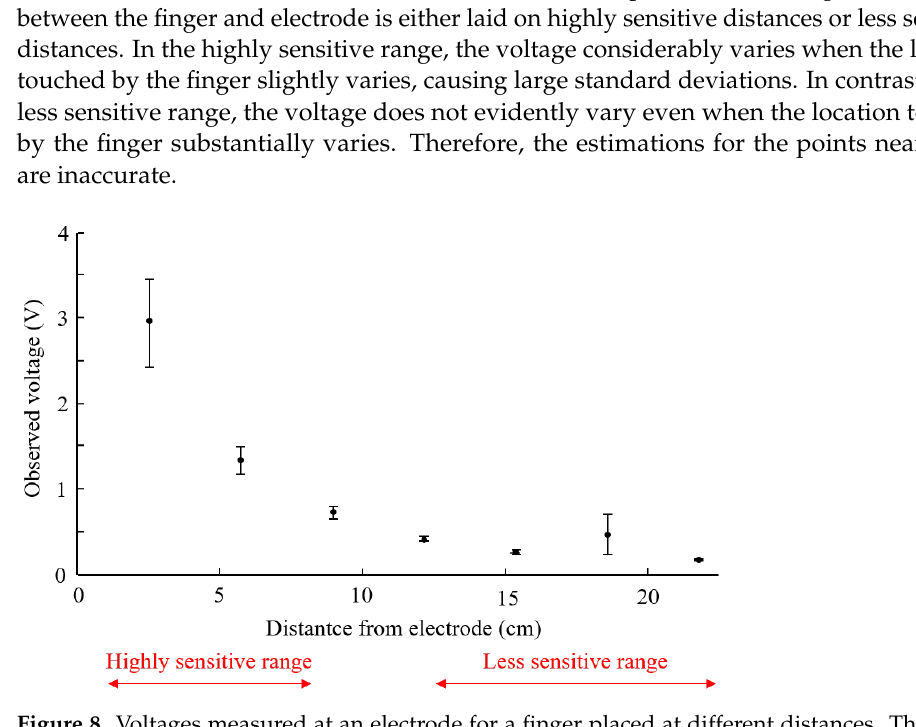
Figure 8. Voltages measured at an electrode for a finger placed at different distances. The points denote the mean voltages for the seven measurements obtained, and the error bars denote the standard